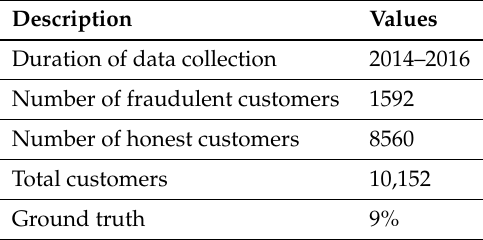
Table 5. Description of